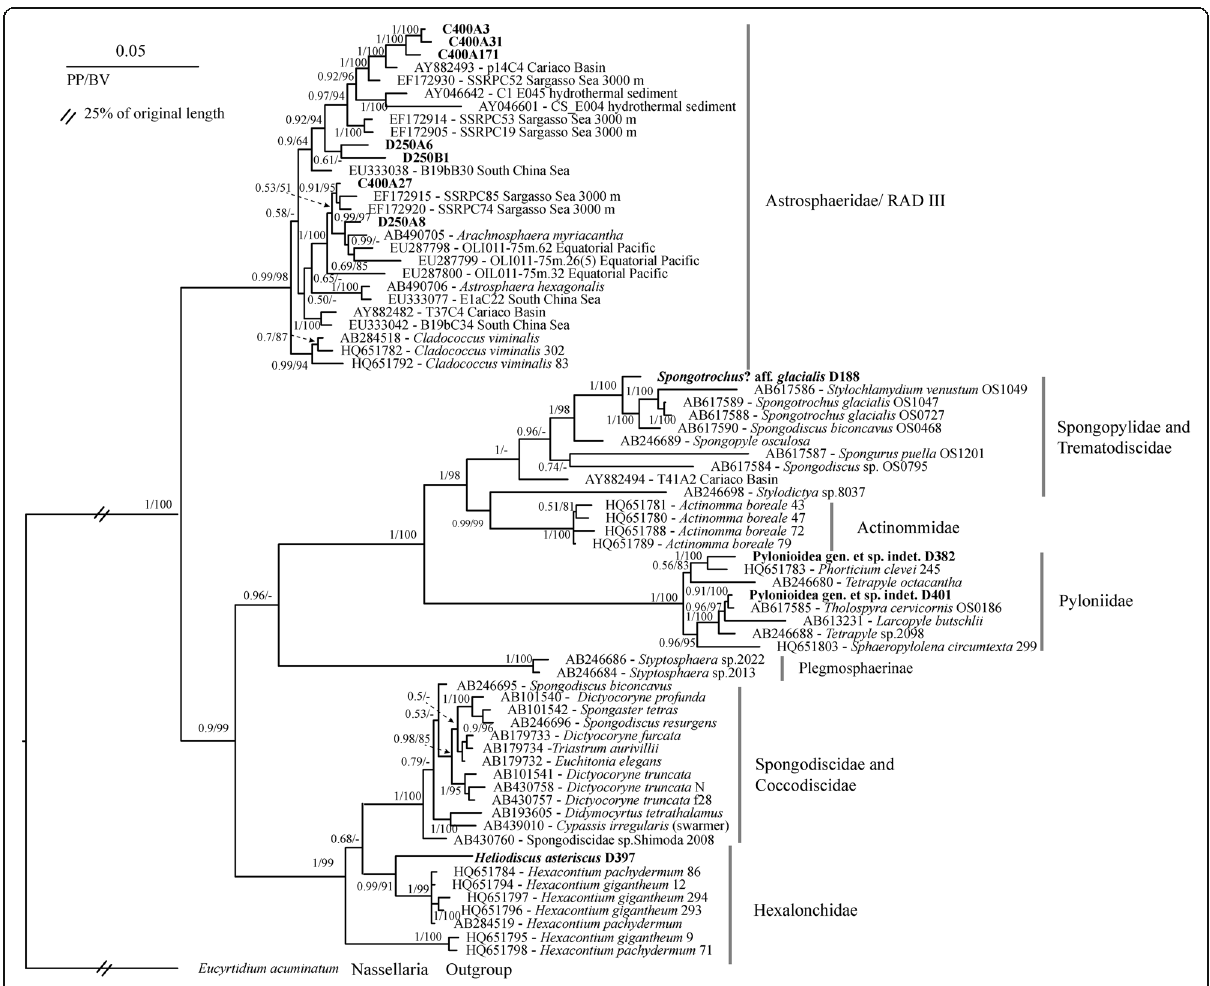
Fig. 2 Phylogenetic tree of spumellarians based on 18S rDNA sequences. Sequences obtained from the Central Pacific Ocean in this study are in bold. Numbers at nodes represent posterior probabilities (PP) of Bayesian inferences, bootstrap values (BV) of the ML analysis. The scale bar in the upper left corner is the substitution rate per site for the Bayesian analyses. Sequences obtained in this study are in bold